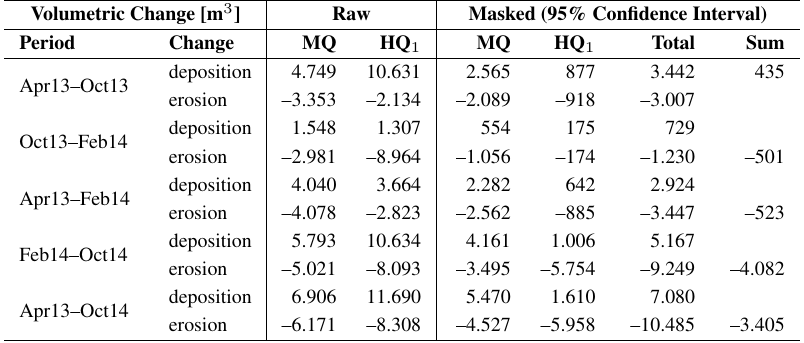
Table 4. Volumetric changes derived from DoD. Separate values are reported for: deposition and erosion, mean flow (MQ) and annual flood (HQ significant (masked)